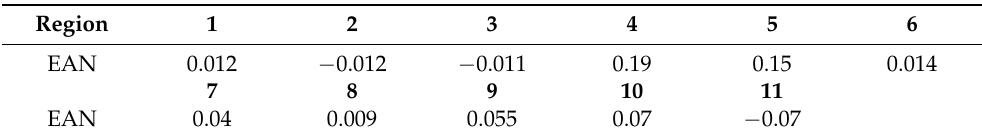
Table 4. BIAS log10 statistics for chlorophyll obtained for BS-BIO NRT, considering the observation minus model prediction pairs for the various regions (1–11) shown in Figure 8 Data are from the L3 CMEMS satellite chlorophyll observations (Table 1).